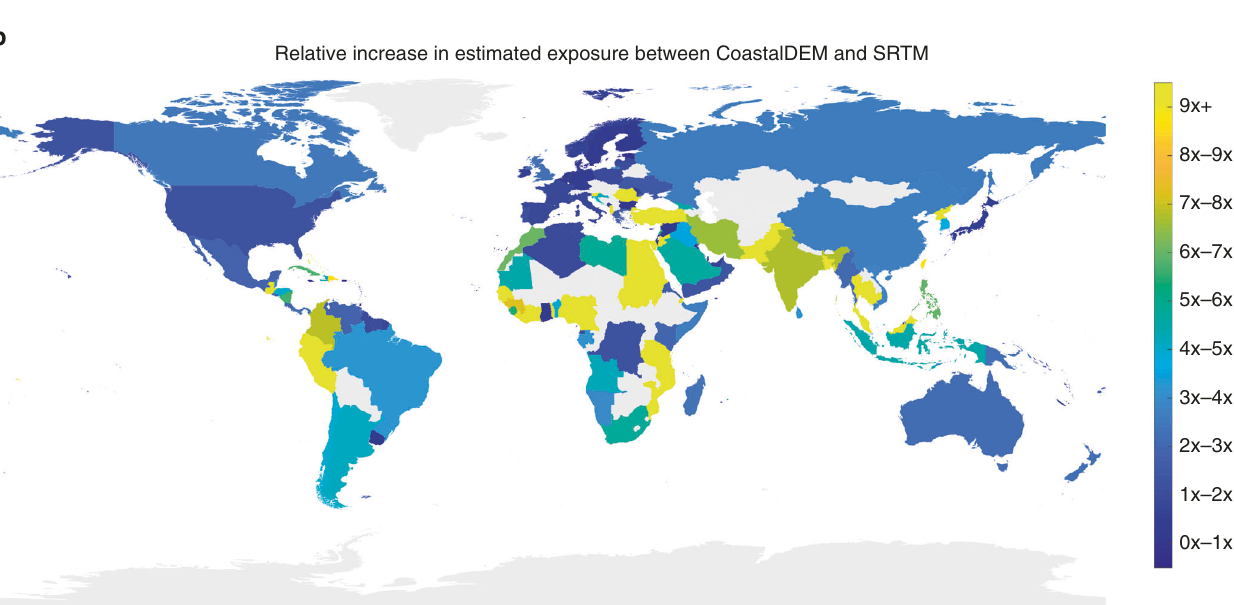
Fig. 2 Total populations on vulnerable land. a Current population on land below projected mean higher high water level in 2100 assuming intermediate carbon emissions (RCP 4.5) and relatively stable Antarctic ice sheets (sea level model K14). Estimates based on CoastalDEM. b Factor by which CoastalDEM increases estimates of people on vulnerable land over SRTM in each country under K14/RCP 4.5. Countries wholly north of 60 degrees N are excluded because CoastalDEM is unde fi ned at those latitudes. Source data are provided as a Source Data fi le. National boundaries based on public domain vector map data by Natural Earth